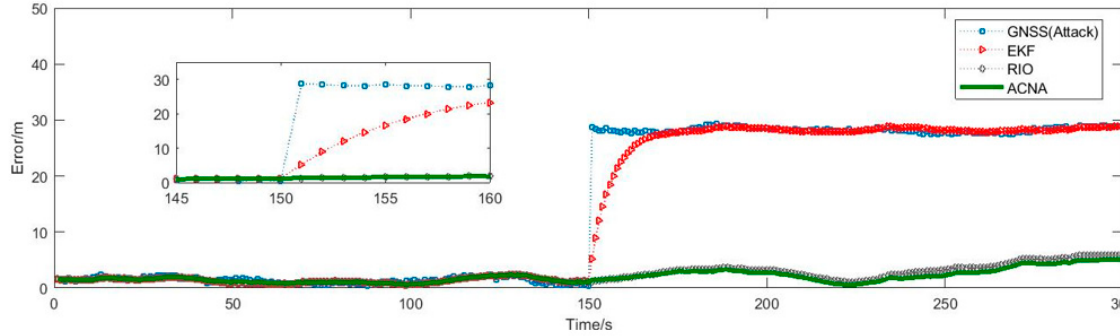
Ψ Ψ  2 . . Figure 13. The position error of the three algorithms on data set (cid:101) 2